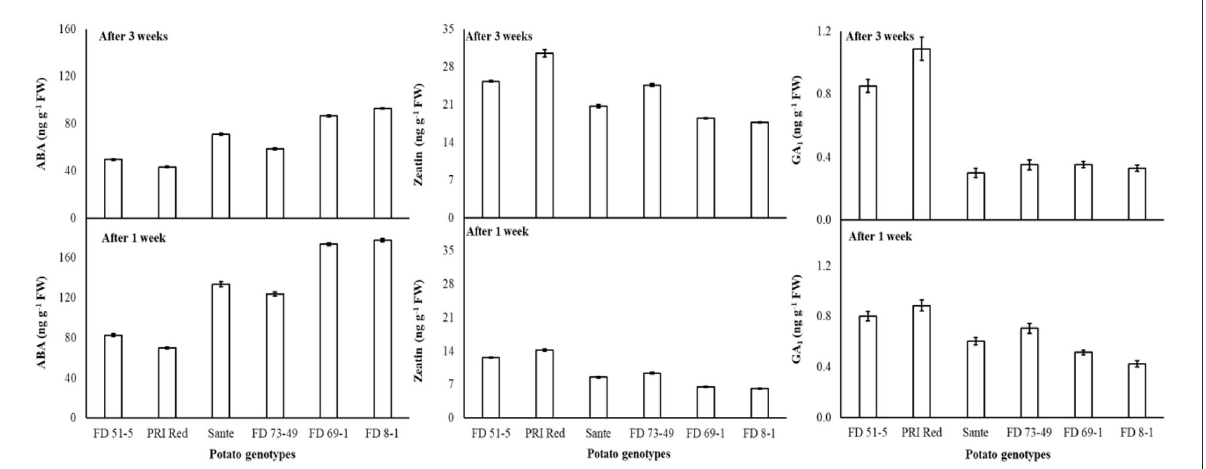
FIGURE7 Change in ABA, ZT, and GA 1 levels in tuber during storage period (3 weeks) following treatment with γ -irradiation. Vertical error bars represent standard error of means (n: